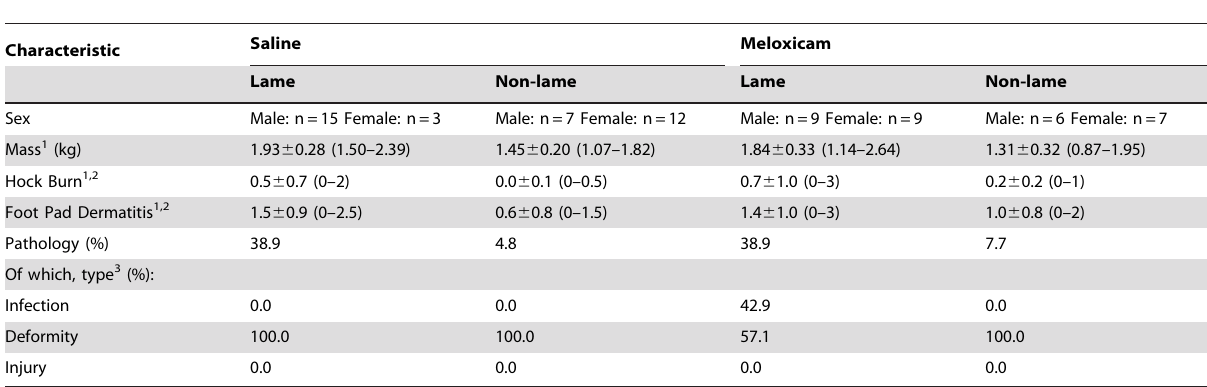
Table 2. Key sample characteristics for birds administered meloxicam or saline (n=68).